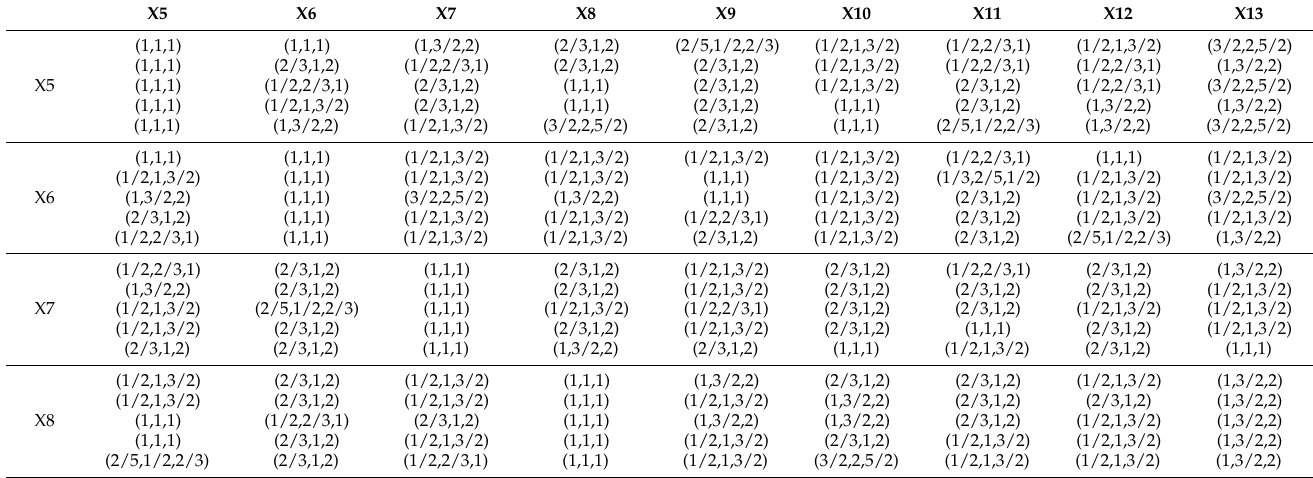
Table A3. Pairwise comparison of the elements in the category of